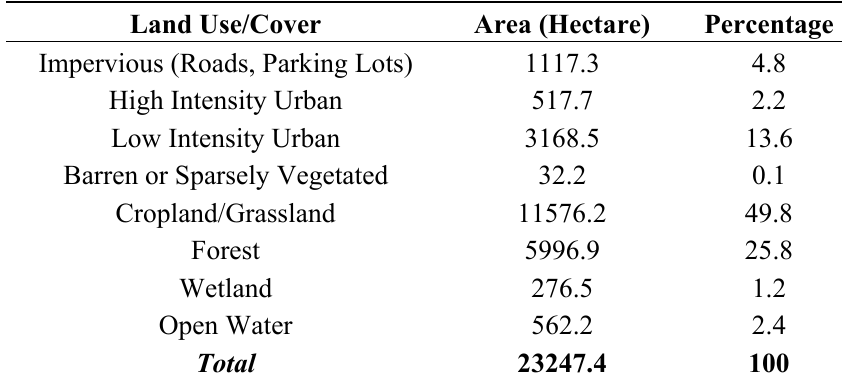
Table 1. Hinkson Creek Watershed Land Use/Land Cover Summary, source: Missouri Spatial Data Information Service